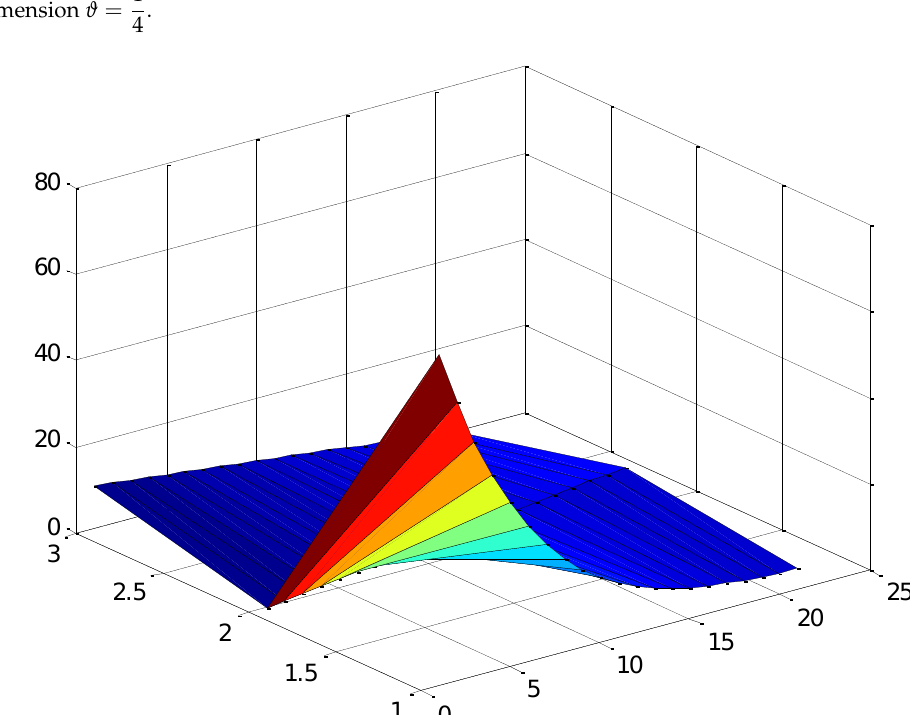
Figure 1: The plot of solution to dissipative wave equation with local fractional operators with fractal dimension .